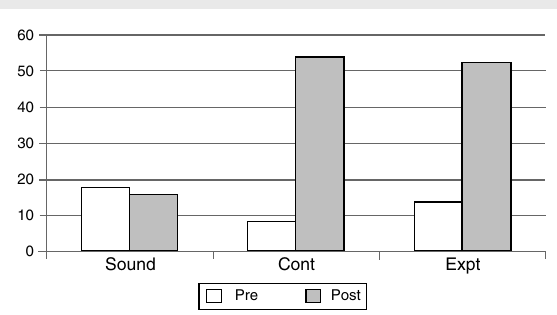
Hearing thresholds (in dB) before and after respec-